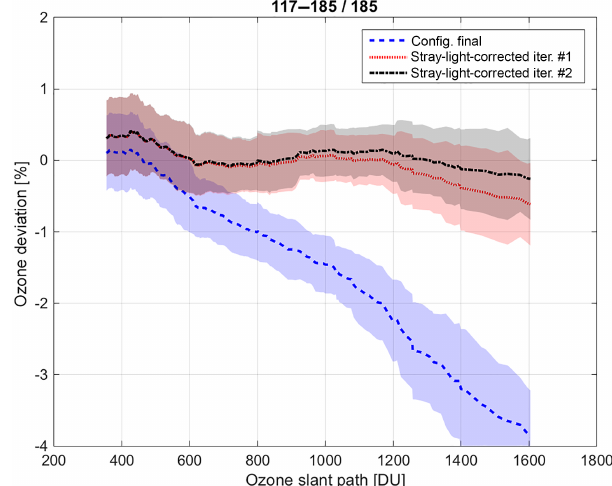
Figure 7. Percentage ozone differences with respect to the reference vs. ozone slant path. In blue, using the final configuration constants, and in black and red, after the stray light correction has been ap- plied, with one and two iterations, respectively. Data are averaged in ± 50DU intervals; the shadow area represents 1 standard devia-